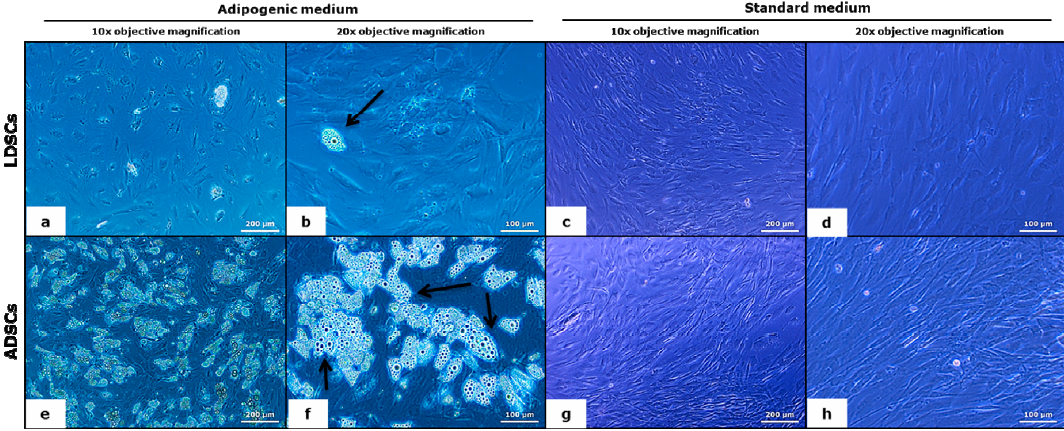
Figure 4. Light microscopic analysis of adipocytes’ formation after 21 day of adipogenic differentiation;